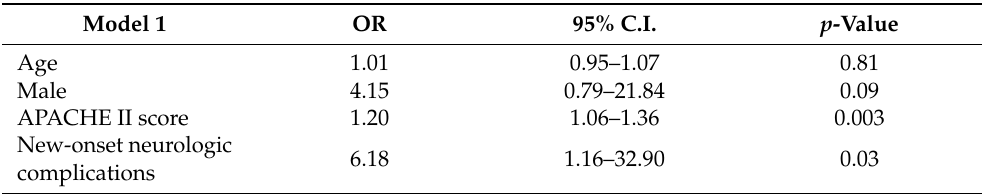
Table 4. Independent predictors associated with ICU mortality in the multiple logistic regression analysis using APACHE II